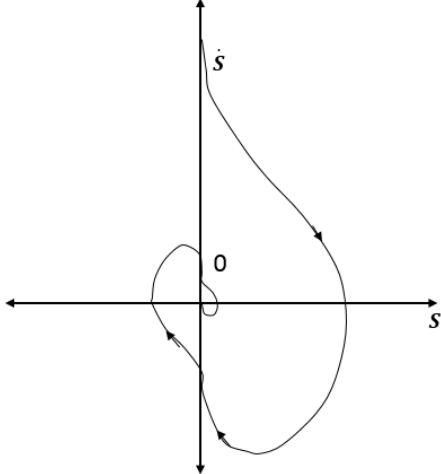
Figure 5. The synoptic diagram of the super-twisting algorithm.